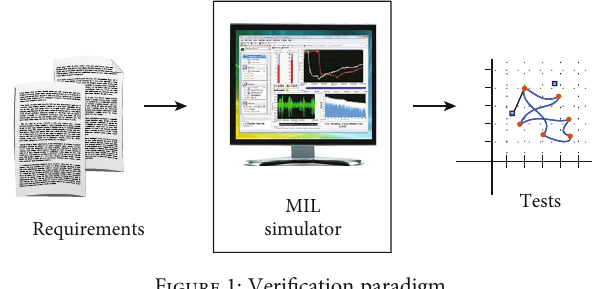
Figure 1: Veri fi cation